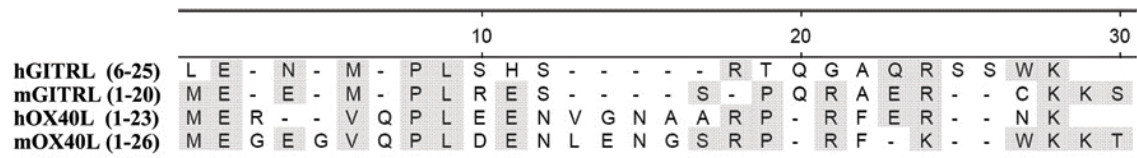
FIGURE 8. Homology between the cytoplasmic domain of GITRL and OX40L Comparison between the cytoplasmic domain of GITRL and OX40L (amino acid position is indicated between brackets). Identical amino acid residues or those with similar function (I, V, M, L; H, R, K; E, D, N, Q; S, T; A, G; Y, F) present in at least 2 sequences belonging to a different gene are shaded. The serine amino acidic residues in dark gray background are potential phosphorilation